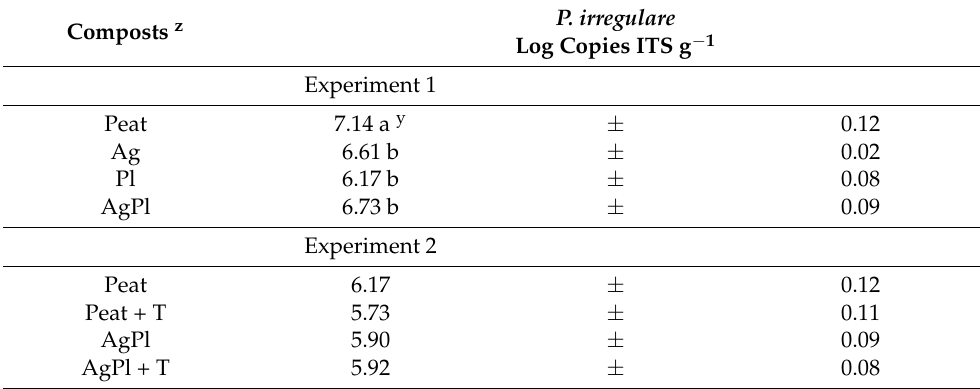
Table 3. Amount of P. irregulare in the different compost growing